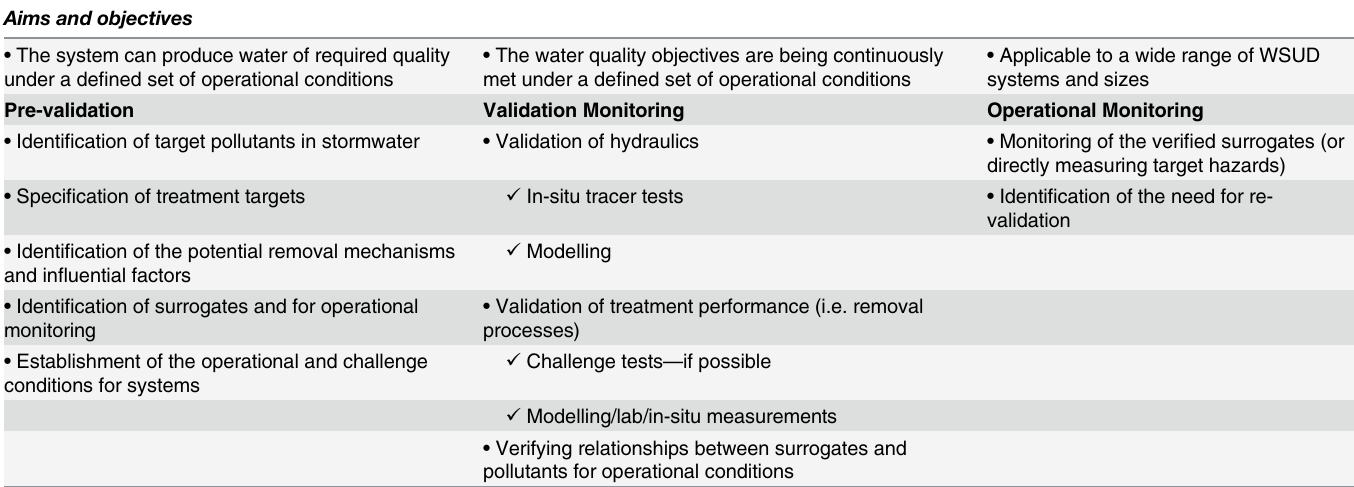
Table 1. Proposed validation framework for WSUD stormwater harvesting systems.